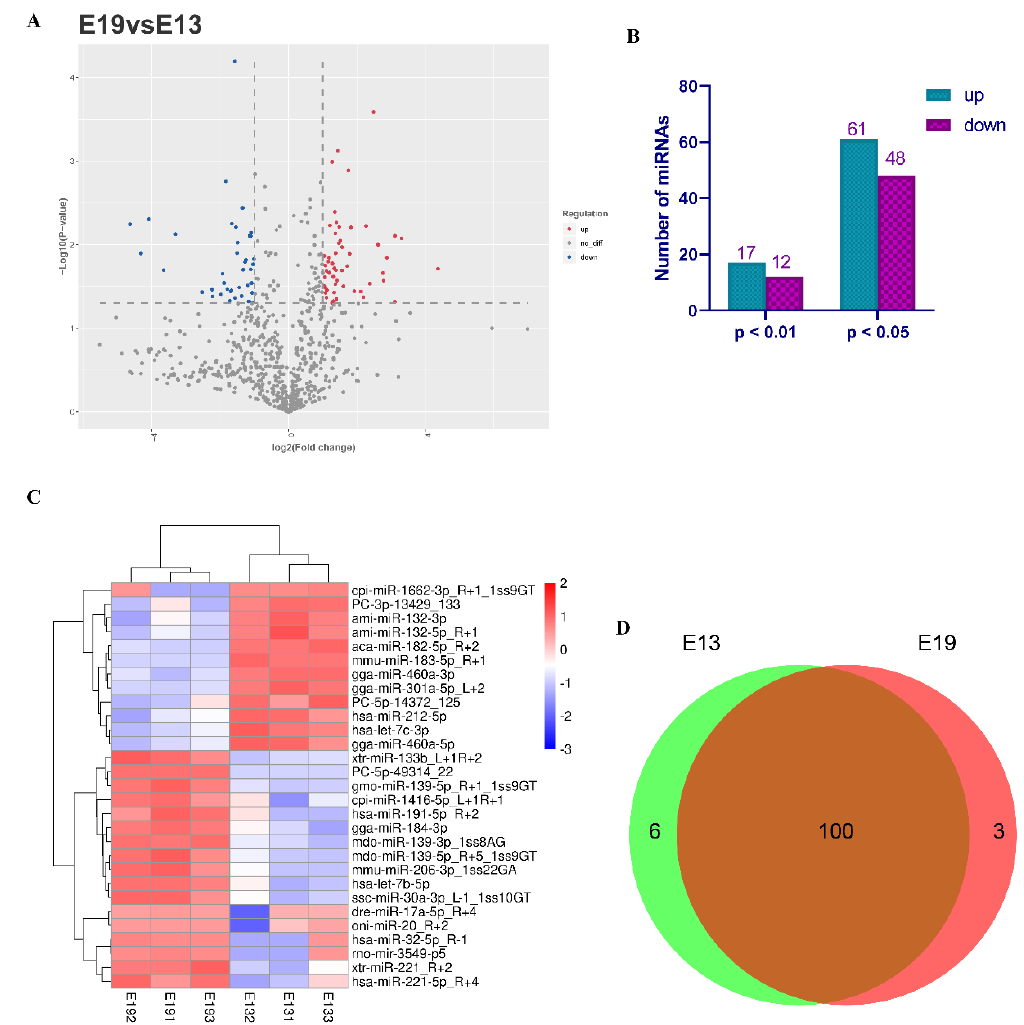
Figure 3. Differentially expressed miRNAs between embryonic day 13 (E13) and E19. ( A ) Volcano chart of miRNAs expressed at E19 vs. E13. Red dots represent up-regulated miRNAs, blue dots represent down-regulated miRNAs, gray dots indicate no difference in expression. ( B ) Numbers of up-regulated and down-regulated miRNAs with p < 0.01 and p < 0.05. ( C ) Heat map of the differentially expressed miRNAs with p < 0.01 at E19 vs. E13 in breast muscle. ( D ) Venn diagrams of differentially expressed miRNAs at E19 vs. E13 in embryonic breast muscle.